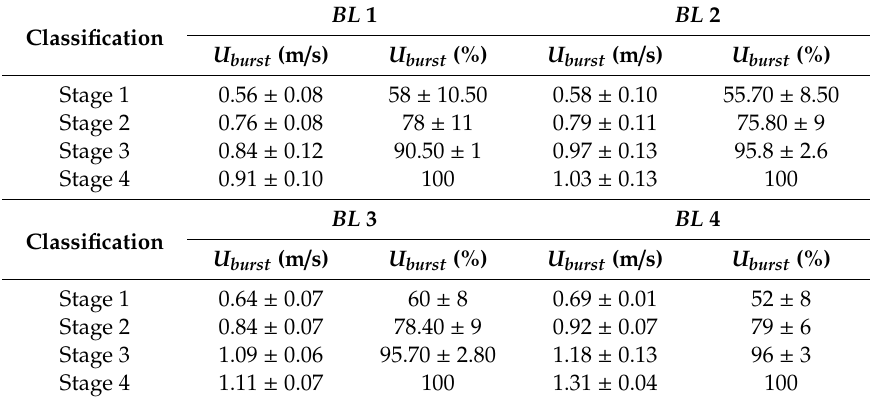
Table 2. Maximum swimming speeds of tested juvenile grass carp with four size groups at four